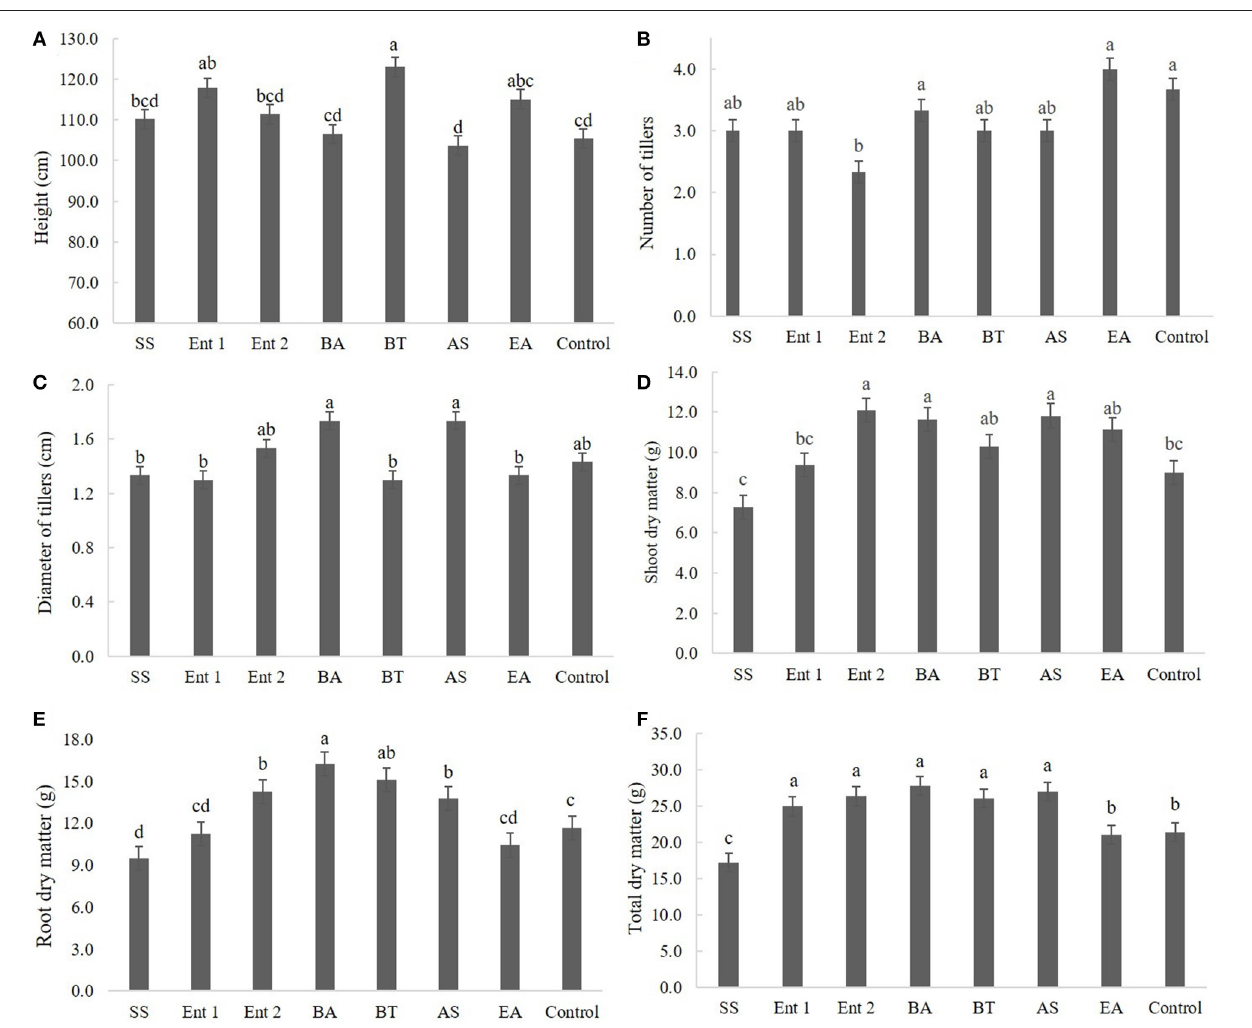
FIGURE 3 | Biometric data of sugarcane plants after 60 days, specifically (A) plant height, (B) number of tillers, (C) diameter of tillers, (D) shoot dry mass, (E) root dry mass, and (F) total dry mass. SS, S. saprophyticus IJ8; Ent 1, Enterobacter sp. IP11; Ent 2, Enterobacter sp. IP14; BA, B. anthracis IP17; BT, B. thuringiensis IP21; AS, A. spanius IP23; EA, E. asburiae IP24; Control, no inoculation.